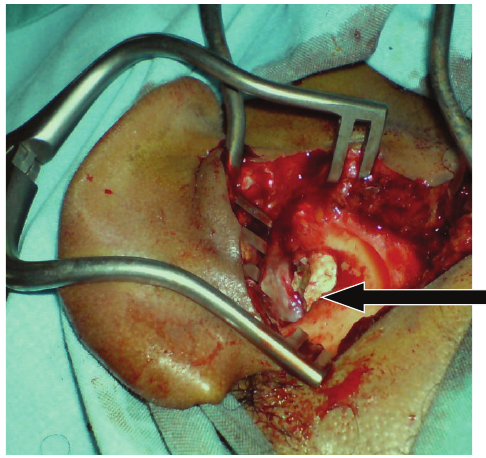
Figure 2: Largely pearly white mass expanding the mastoid